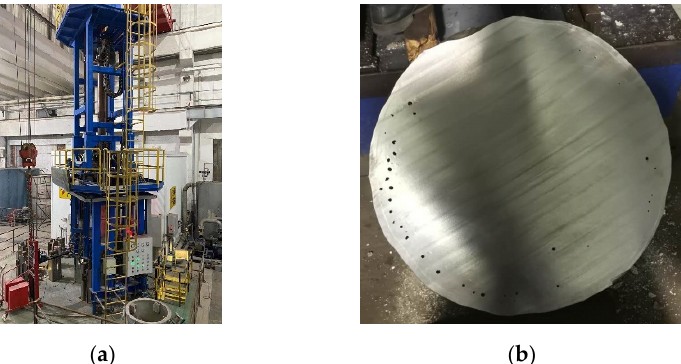
Figure 1. The picture of ( a ) ESR furnace, and ( b ) ESR ingot with porosity defects. Notes: Figure 1 was taken from the authors’ ESR